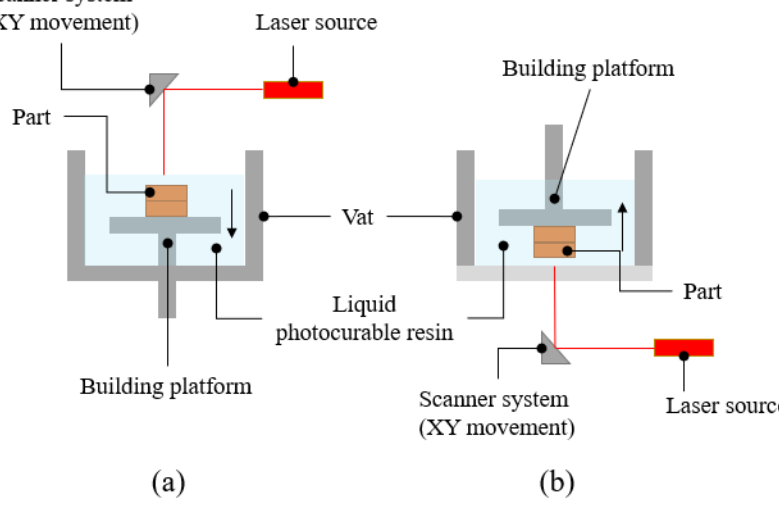
Figure 1. Stereolithography process: ( a ) top-down and ( b ) bottom-up apparatus.